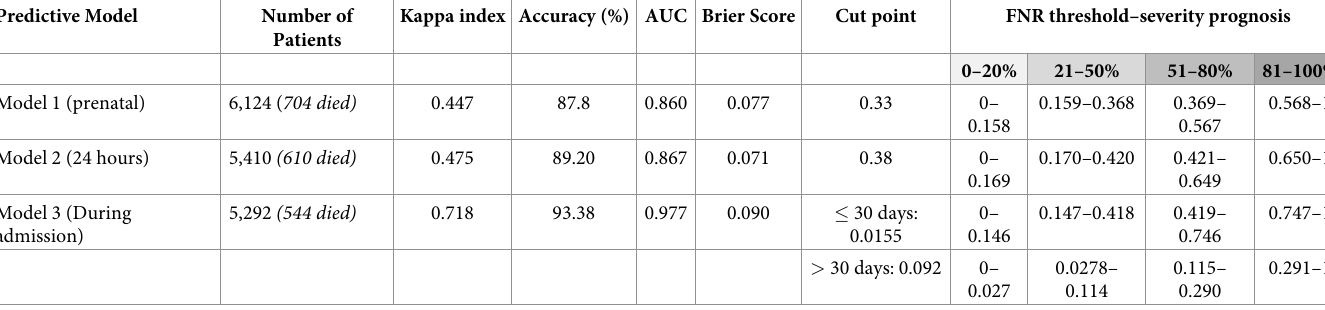
Table 4. Validation of predictive formulas and summary of cut-off points of the best models according to FNR (false negative